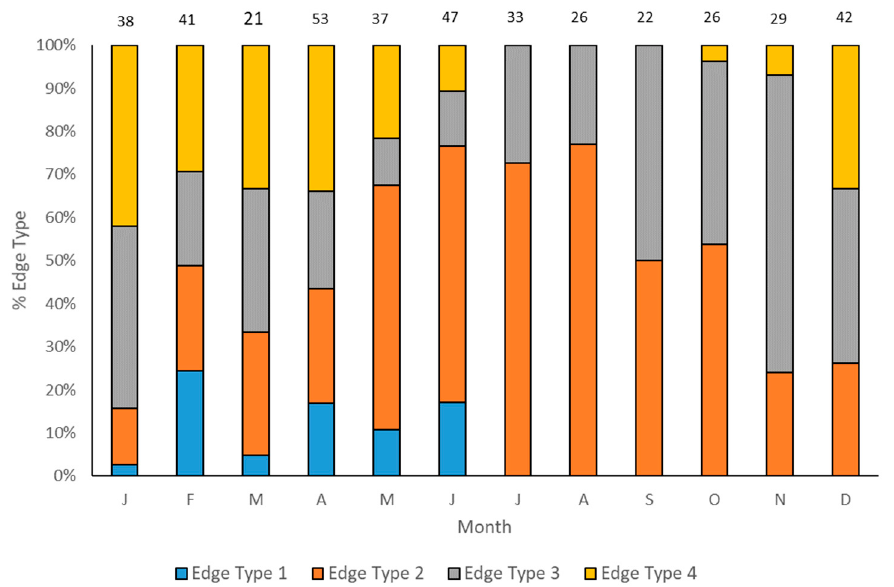
Figure 2. Monthly percentages of all edge types for margate ( Haemulon album ) collected from the Southeastern United States from 1979 to 2017, with total sample sizes above each column. Edge codes: 1 = opaque zone on edge, indicating annulus formation; 2 = small translucent zone, <30% of previous increment; 3 = moderate translucent zone, 30%–60% of previous increment; 4 = wide translucent zone, >60% of previous increment [16].